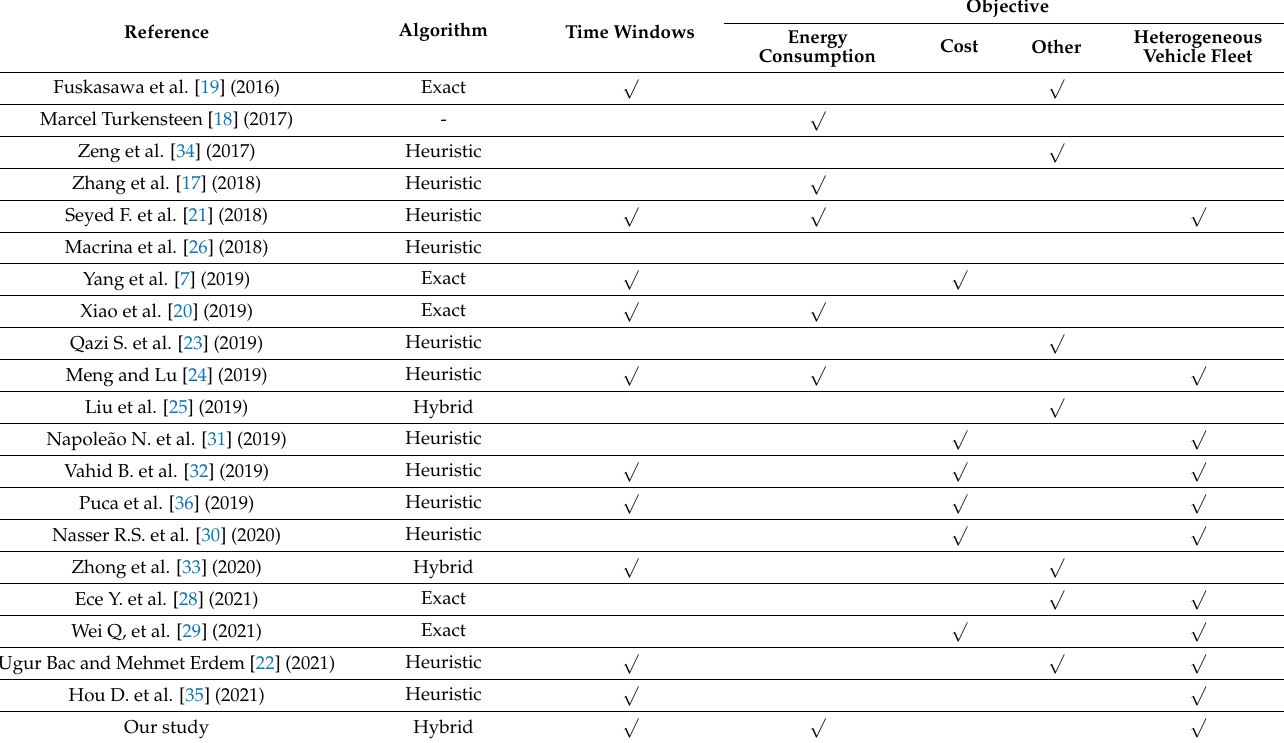
Table 1. Tabular form of the related